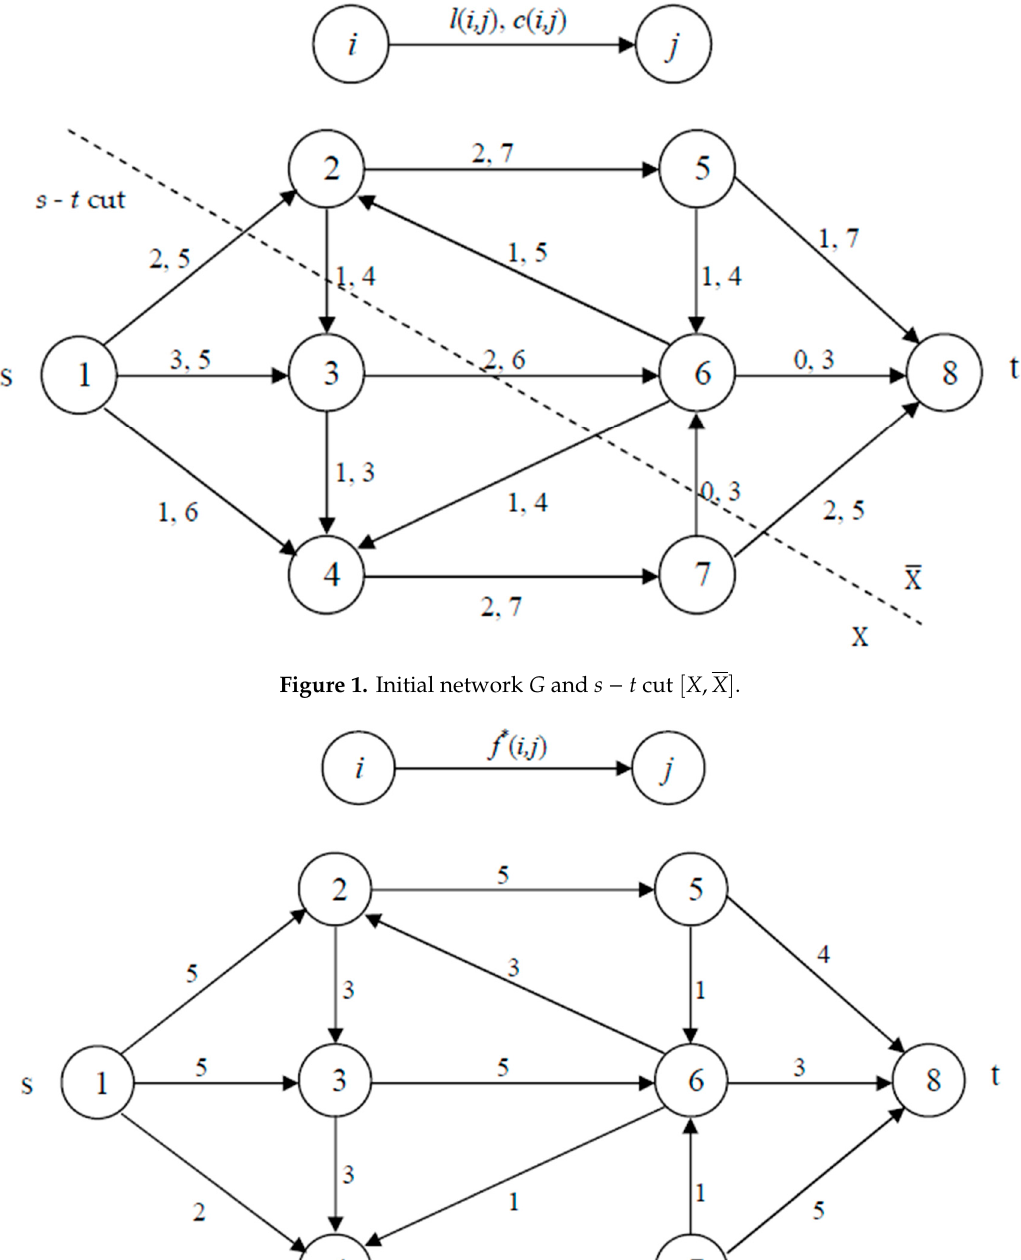
Figure 2. Maximum flow f ∗ in G .